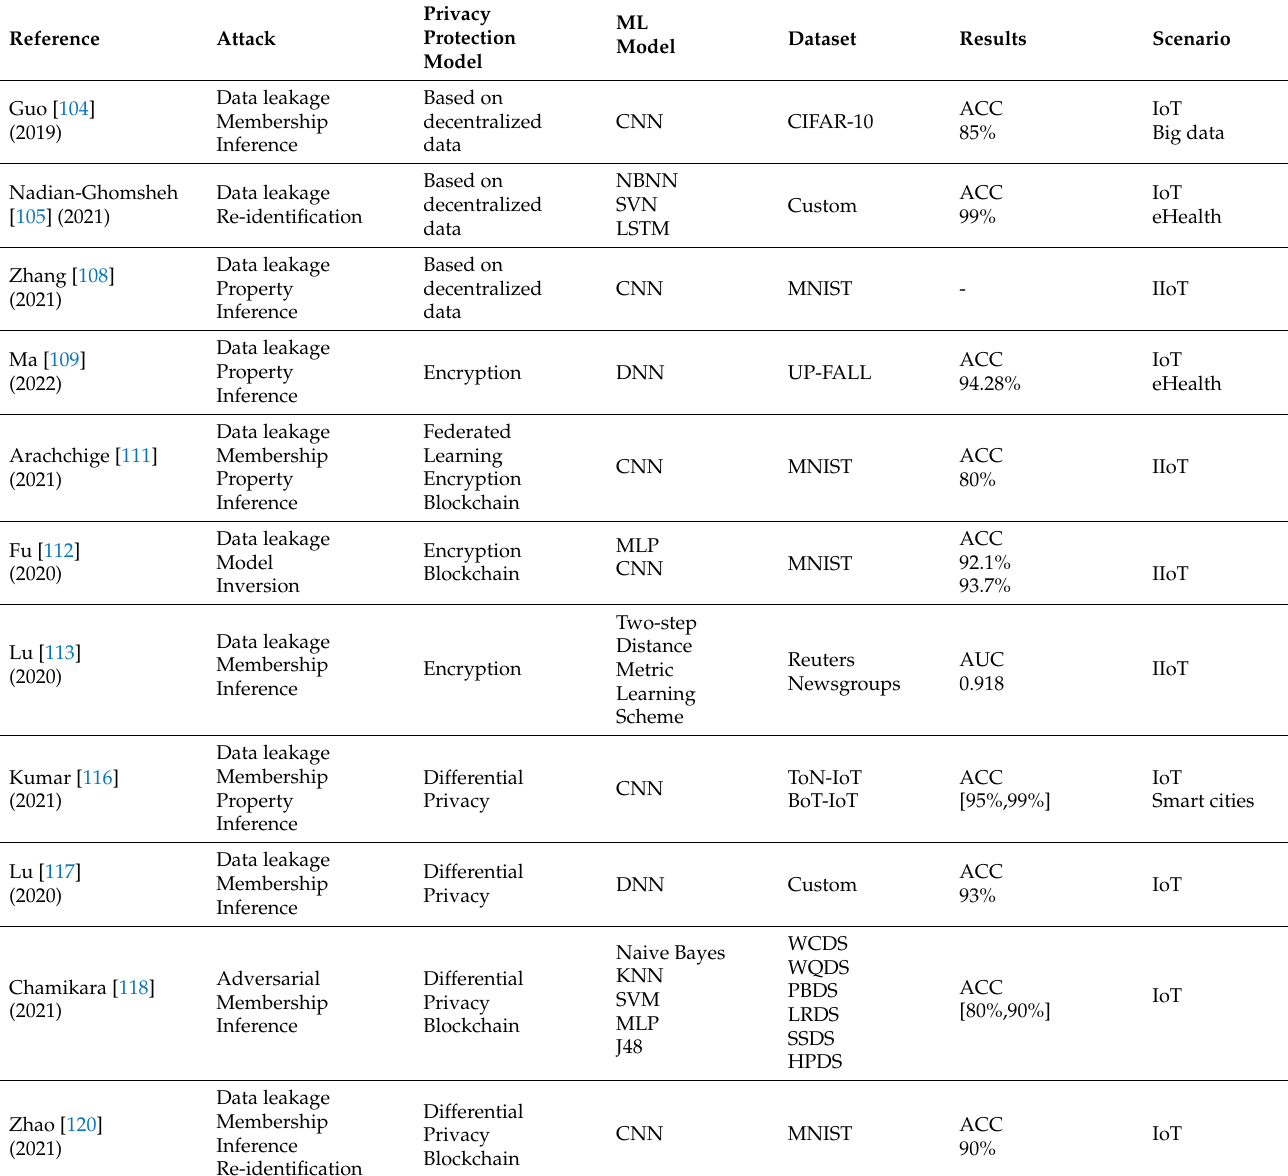
Table 4. ML-based privacy works in IoT environments—Federated